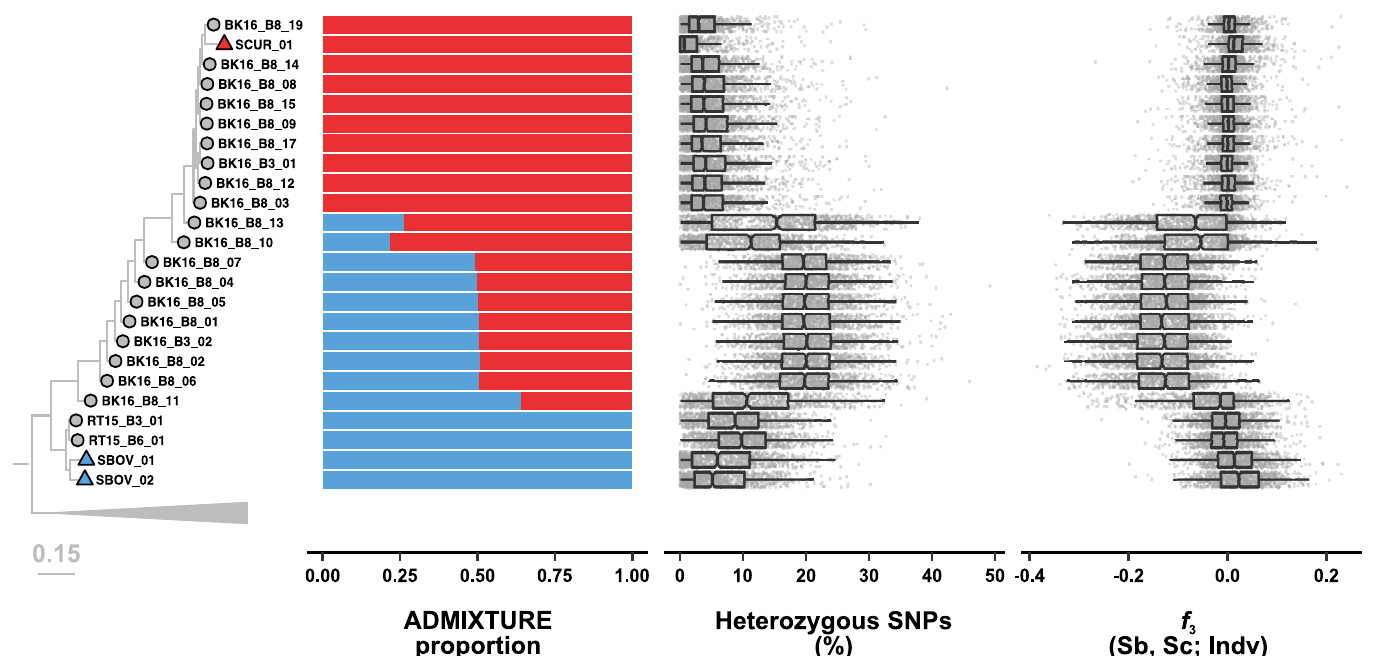
Fig 3. Evidence of admixture in sequenced samples. The phylogeny and admixture proportion estimates are identical to Fig 2. We calculated the proportion of heterozygous variants per 50 kb windows along each autosome. The three-population statistic ( f 3 ) was used to test for admixture between each test sample and both reference populations for each species. We defined three populations described by the tree ((P1,P2),P3)). We designated reference populations for S . bovis and S . curassoni as P1 and P2, respectively. Individual samples to be analysed were designated at P3.